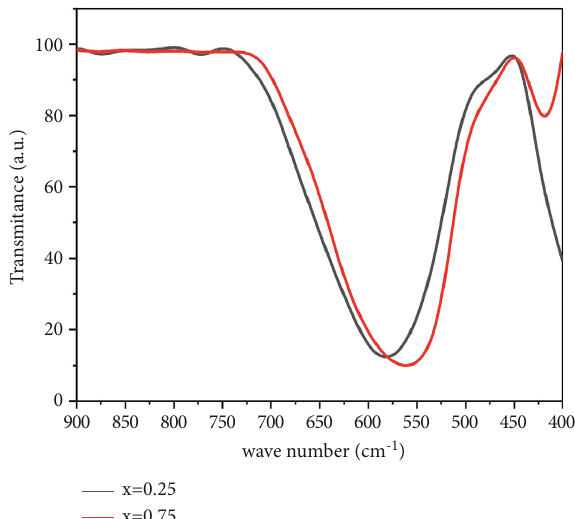
0.75 Zn 0.25 Fe 2 O 4 and (b) Ni 0.25 Zn 0.75 Fe 2 O 4 annealed at 750